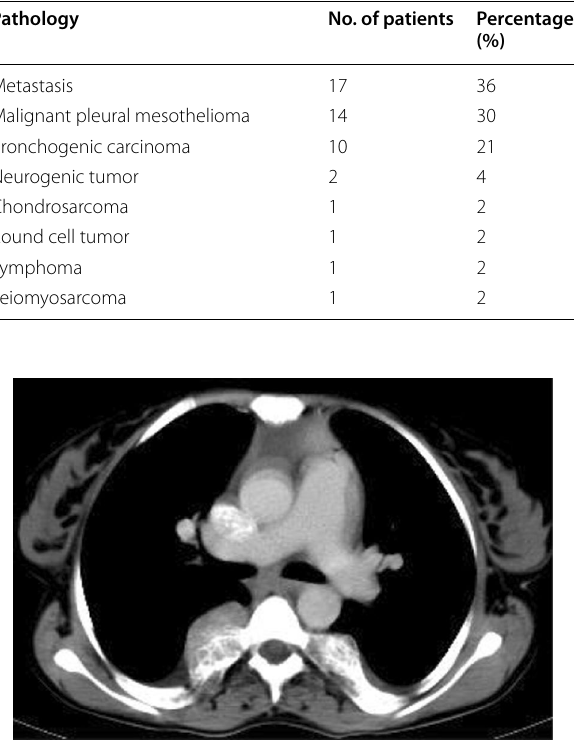
Fig. 4 24‑year‑old female patient with known history of thalassemia presented with chest pain. Axial CT mediastinal window image of the upper chest showing paravertebral calcified extramedullary hematopoiesis involving the EPS